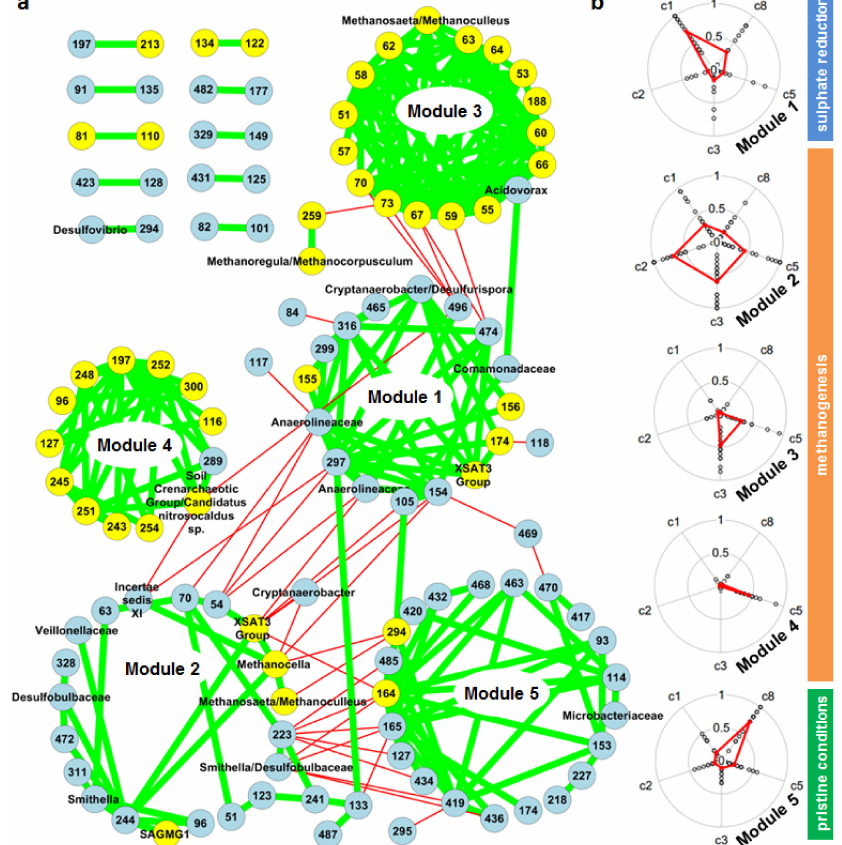
Figure 2. The co-occurrence network contains five modules whose presence varies along the flow path. The network is based on bulk soil samples and Rsa I digestion. ( a ) Bacterial fragments (light blue nodes) and archaeal fragments (yellow nodes) are connected by green edges for positive (co-occurrence) and thin red edges for negative correlations (mutual exclusion). Fragments belonging to modules as discovered by network analysis are arranged on circles; ( b ) Modules’ presence along the flow path (cores C1, C2, C3, and C5) and in the pristine environment (C8) is shown in radial plots detailing the presence of individual module fragments (symbols) and module mean (red line), with values ranging from 0 (fragment not present in any core sample) to 1 (fragment present in all core samples). According to geochemical data, sulphate reduction was limited to core C1, while methanogenesis took place in cores C2, C3, and